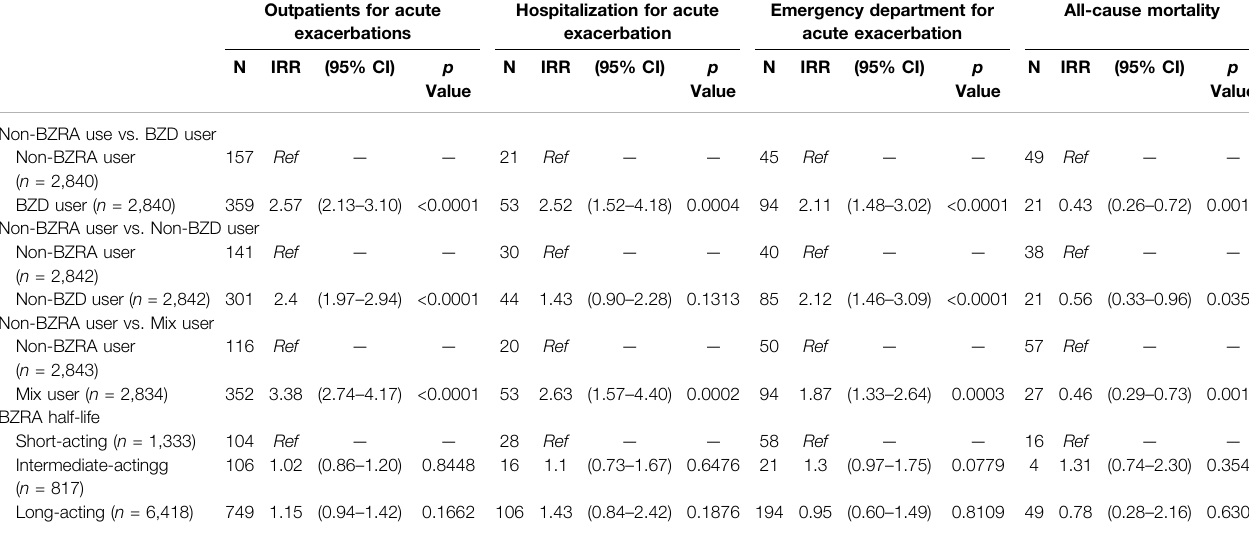
TABLE 4 | The incident rate ratio for study outcomes in poisson regression of different groups and half-life sensitivity analysis. Outpatients for acute Hospitalization for acute exacerbations